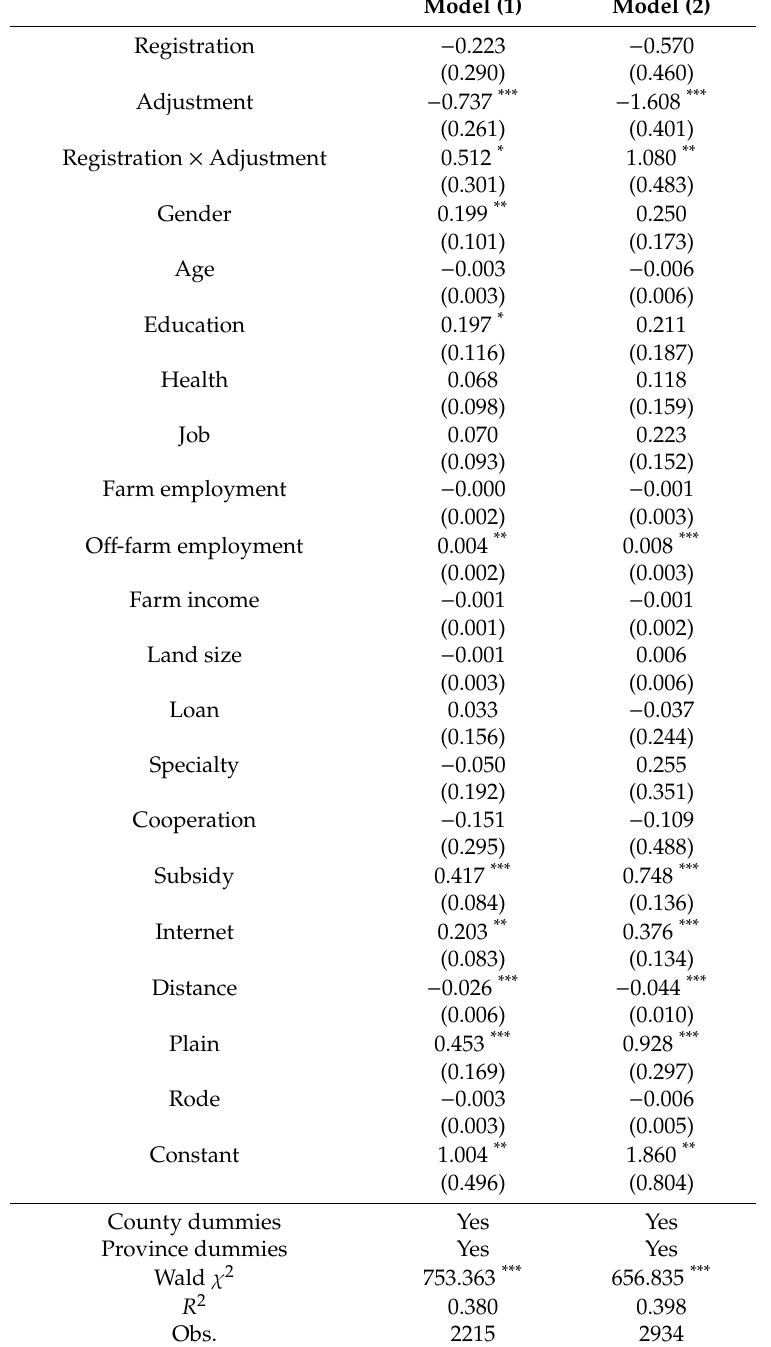
Table 3. The estimated results of robustness